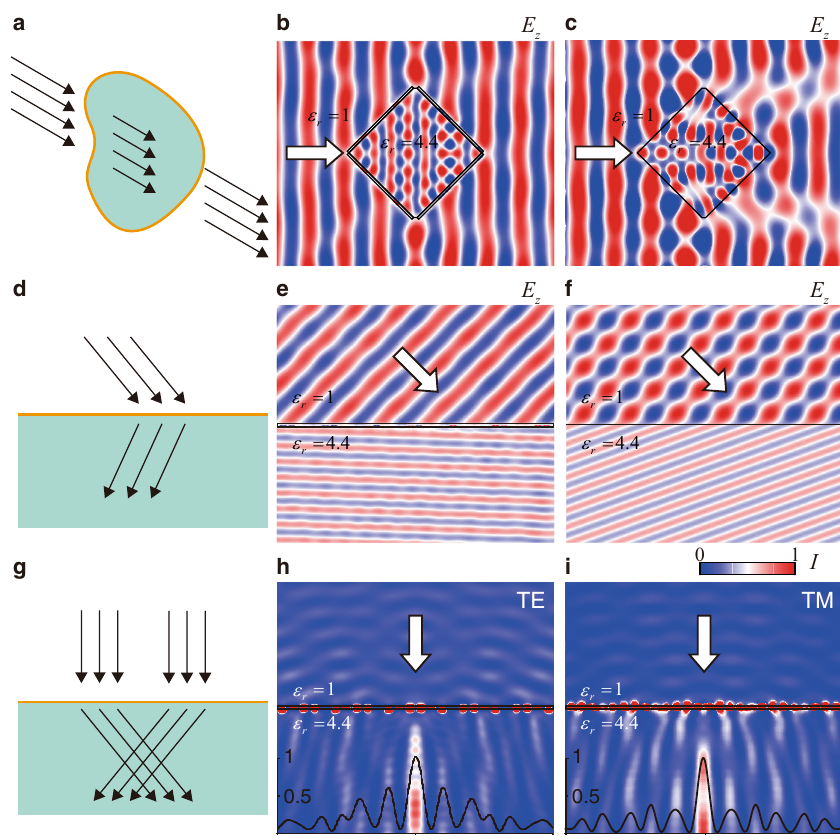
Fig. 5 Several phenomena and re fl ection-less devices enabled by GAMs. a Schematic diagram of an invisible dielectric object by covering it with GAM. b , c Simulated electric fi eld distributions of a diamond dielectric object covered with ( b ) and without ( c ) the GAM. d Schematic diagram of re fl ection-less negative refraction on a dielectric surface. e , f Simulated electric fi eld distributions of a dielectric surface with ( e ) and without ( f ) the GAM. g Schematic diagram of a re fl ection-less fl at axicon on a dielectric surface. h , i Simulated distributions of intensity for the designed re fl ection-less fl at axicon under illumination of TE ( h ) and TM ( i ) polarized incident waves. The solid curves in ( h ) and ( i ) depict the normalized intensity along the bottom boundary of ( h ) and ( i ), respectively. White arrows depict the incident waves. Relative permittivity of the dielectrics is 4.4. GAMs in b and e are composed of the meta- atoms shown in Fig.2. Details of GAMs in h and i are shown in Supplementary